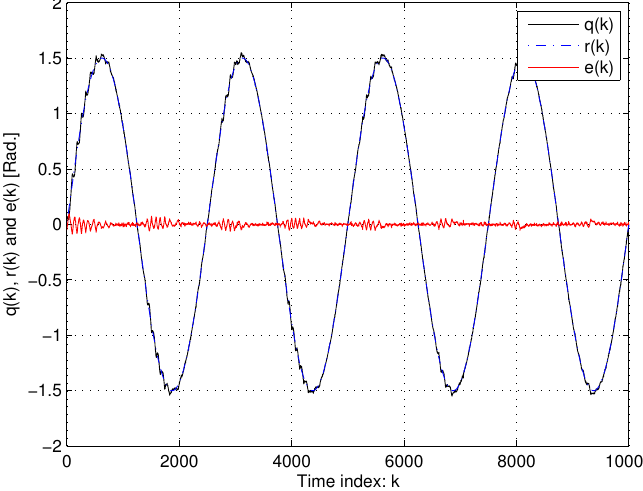
Figure 6. Tracking performance: q ( k ) and e ( k )